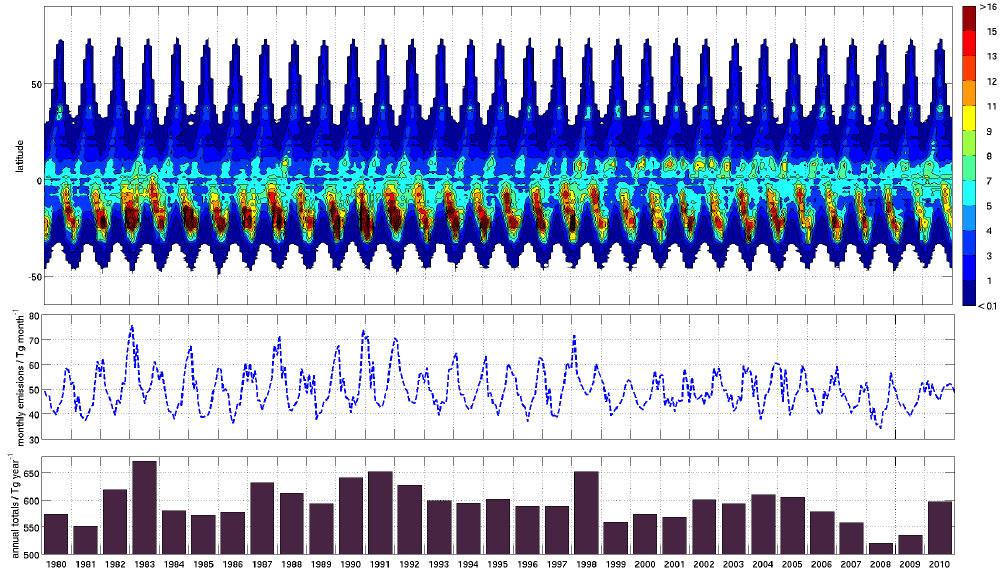
Figure 3. Zonal averages of monthly mean isoprene emissions (mgm − 2 day − 1 ) (top panel), temporal profile of isoprene global monthly totals (Tgmonth − 1 ) (mid-panel), global annual totals of isoprene (Tgyr − 1 ) (bottom panel) for the period of 1980–2010 from the MEGAN– MACC data set. Note that the vertical axis for annual totals starts at 500Tgyr − 1